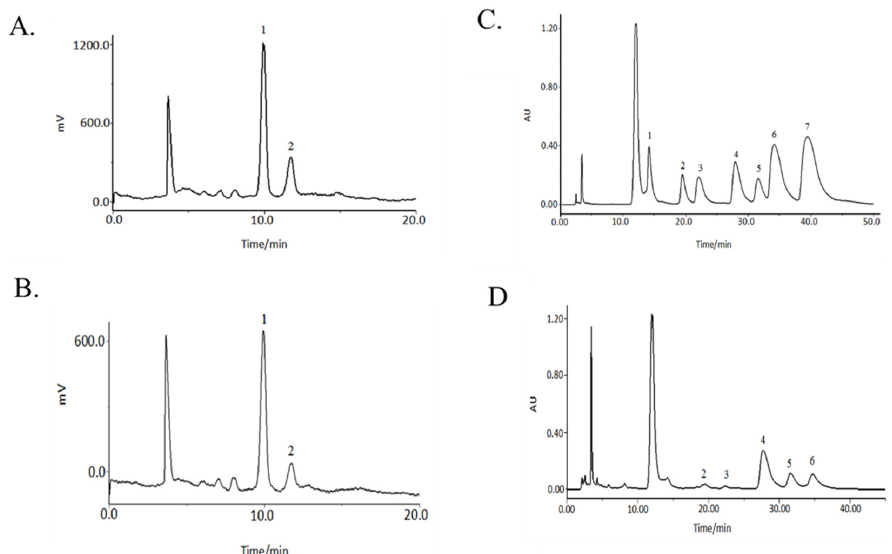
Figure 2. Monosaccharide chromatograms of reference substances ( A ) and PSDSs ( B ) by HPLC- ELSD; monosaccharide chromatograms of reference substances ( C ) and PSDSs ( D ) by HPLC-UV. ( A , B ) (1: Fru; 2: Glc); ( C , D ) (1: Man; 2: Rha; 3: GalA; 4: Glc; 5: Gal; 6: Ara; 7: Fuc).